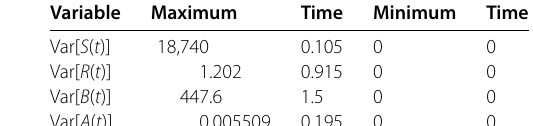
Table 5 Extremum values of the variances